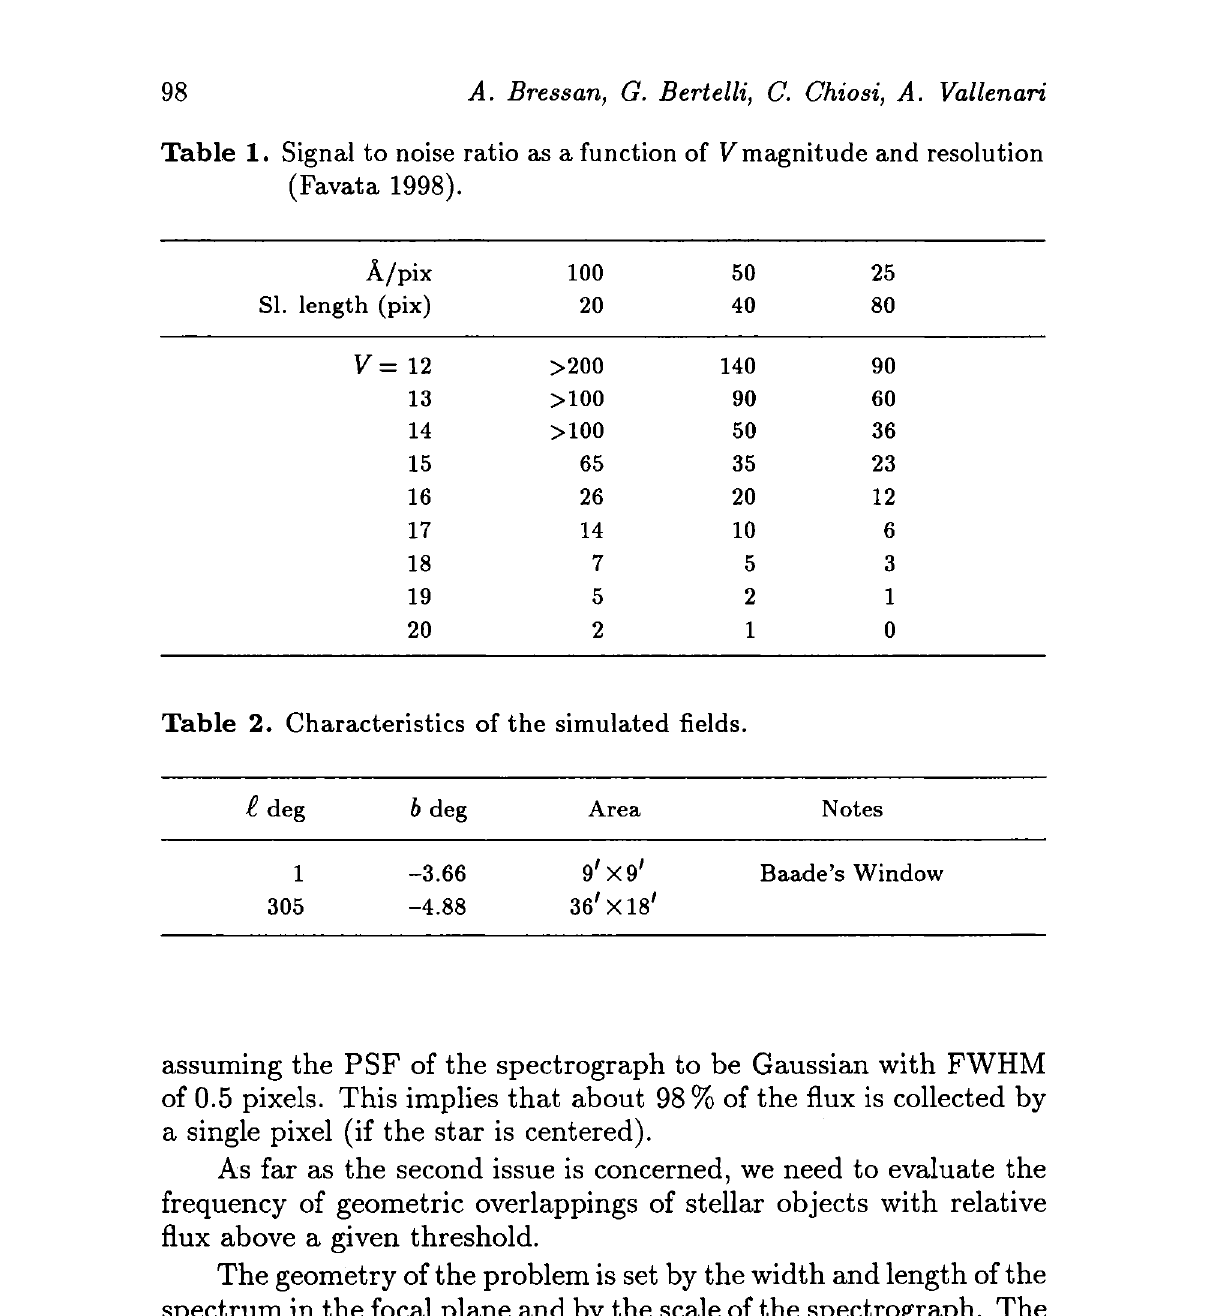
Table 2. Characteristics of the simulated fields. £deg b deg Area Notes 1 -3.66 9'X9' Baade's Window 305 -4.88 36'